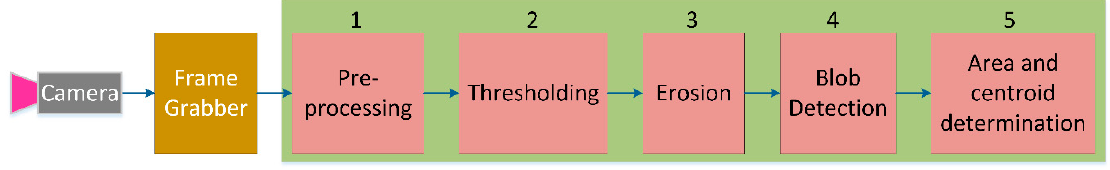
Figure 2. Computer vision components.